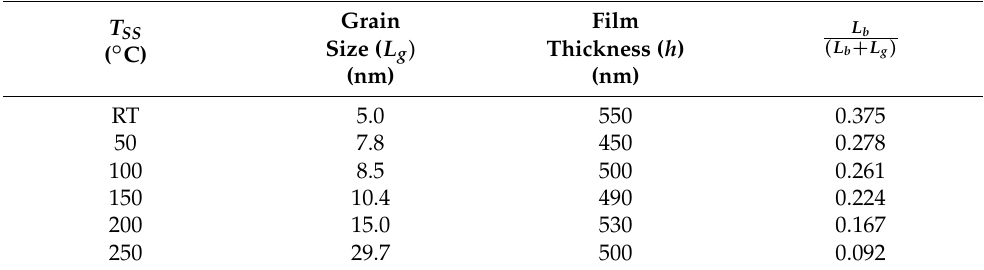
Table 1. Mo film sizes and their grain sizes for various substrate temperatures (a grain boundary size L b of 3 nm was